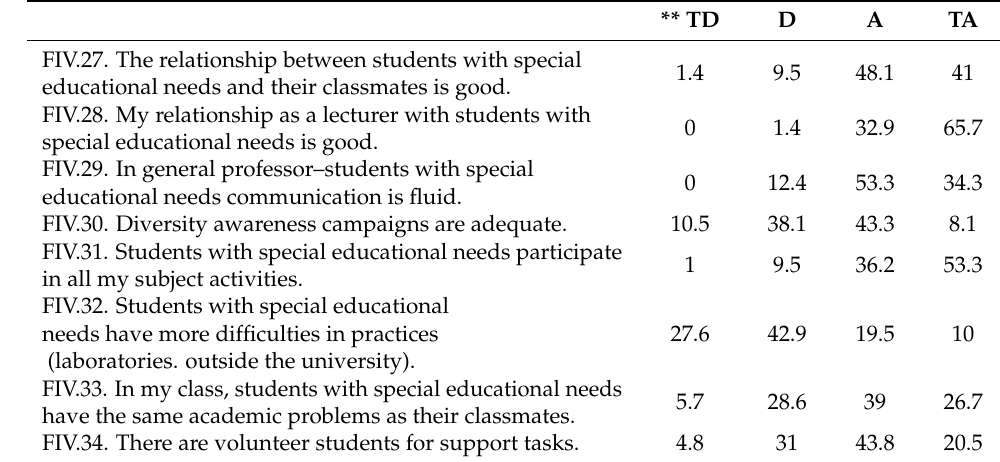
Table 7. Factor IV: Relationships and participation of students with disabilities and other classmates- lecturers (percentage of